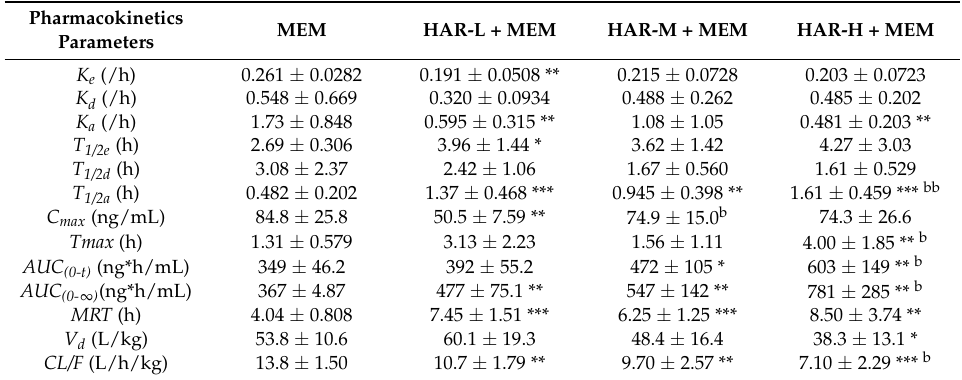
Table 1. Pharmacokinetics parameters of MEM in rats after single administration of MEM at a dose of 5.0 mg/kg and oral administration of low (20.0 mg/kg), medium (40.0 mg/kg) and high (80.0 mg/kg) doses of HAR combined with MEM (5.0 mg/kg) (n = 8, mean ± SD).